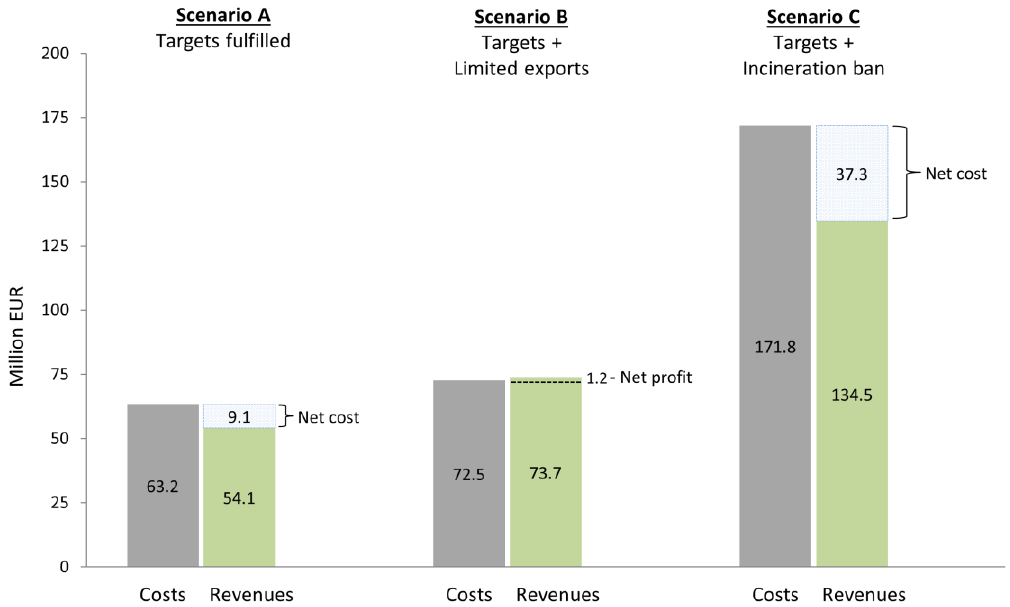
Figure 3. Economic costs and benefits of increased plastic recycling across the value chain.